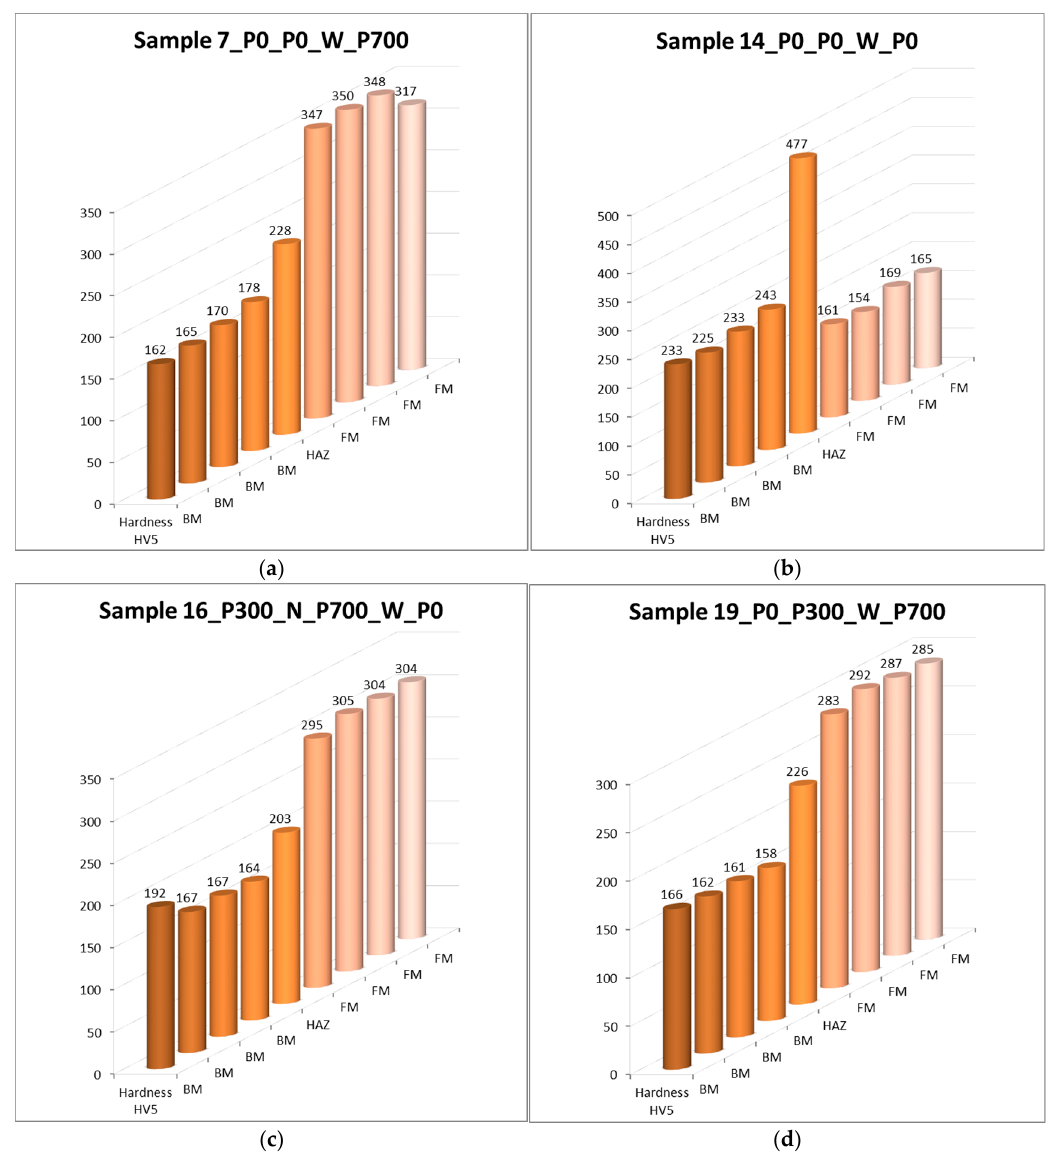
Figure 6. Hardness inspection results; ( a ) hardness profile for sample 7_P0_P0_W_P700 (UTS = 434.7 MPa); ( b ) hardness profile for sample 14_P0_P0_W_P0 (UTS = 344.7 MPa); ( c ) hardness profile for sample 16_P300_N_P700_W_P0 (UTS = 401.8 MPa); ( d ) hardness profile for sample 19_P0_P300_W_P700 (UTS = 405.7